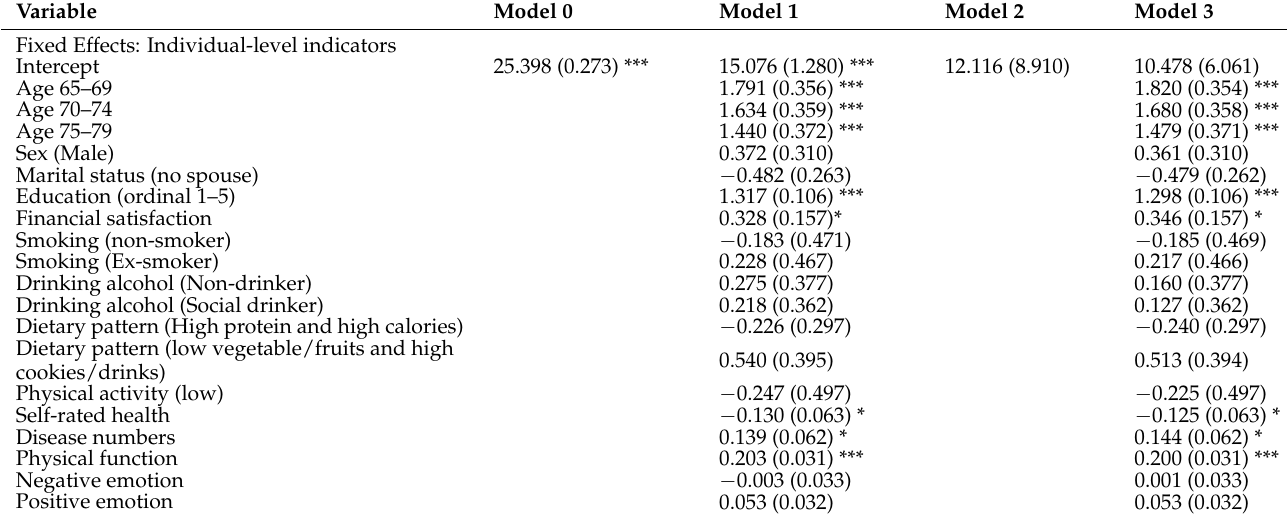
Table 4. City- and individual-level factors associated with cognitive function for older adults in Taiwan in 2013–2016 by a mixed-effect